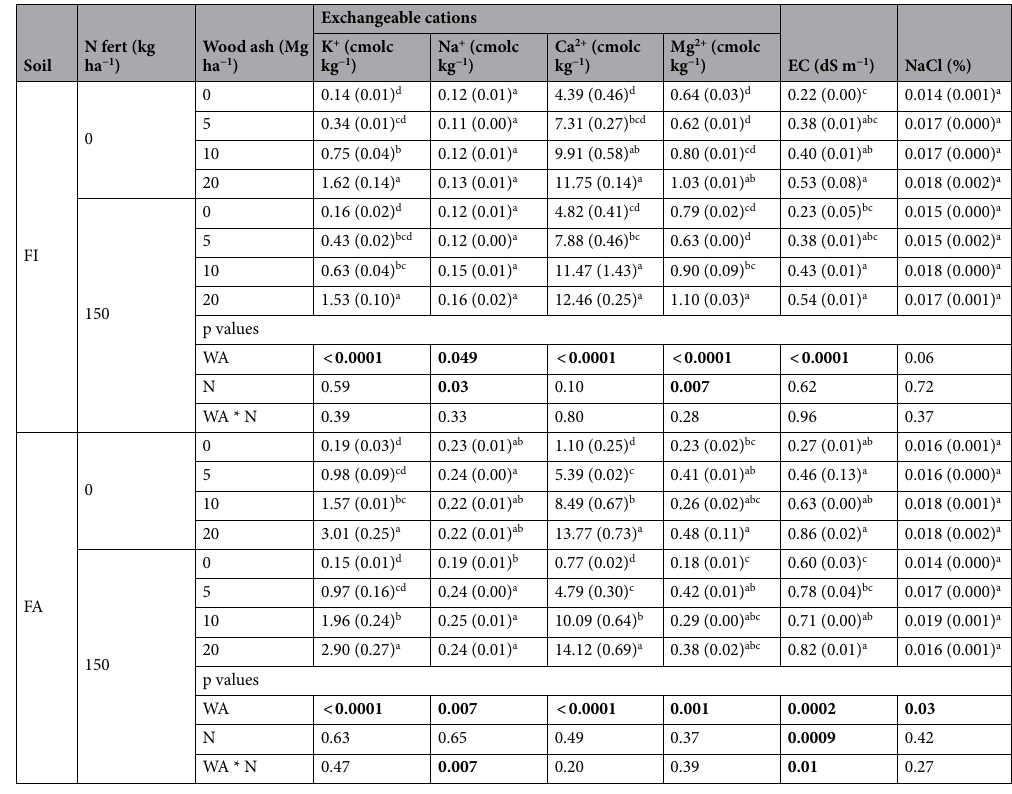
Table 1. Soil chemical properties applied with four levels of wood ash (WA; 0, 50, 10, and 20 Mg ha −1 ) and two levels of N fertilizer (N fert; 0 and 150 kg ha −1 ) across three different soil types (LS, landfill saline soil; FI, forest infertile soil; FA, forest acidic soil) at the end of this study (20 weeks after treatment). Standard errors are shown in parentheses (n = 2). P values are from the result of two-way ANOVA to detect the effect of wood ash and N fertilizer on each soil property within each soil type. Significant p values are in bold. Different lower case letters within each soil indicate significant differences (p < 0.05, Tukey–Kramer comparison lines for least squares means) in each soil property across four wood ash levels and N fertilizer